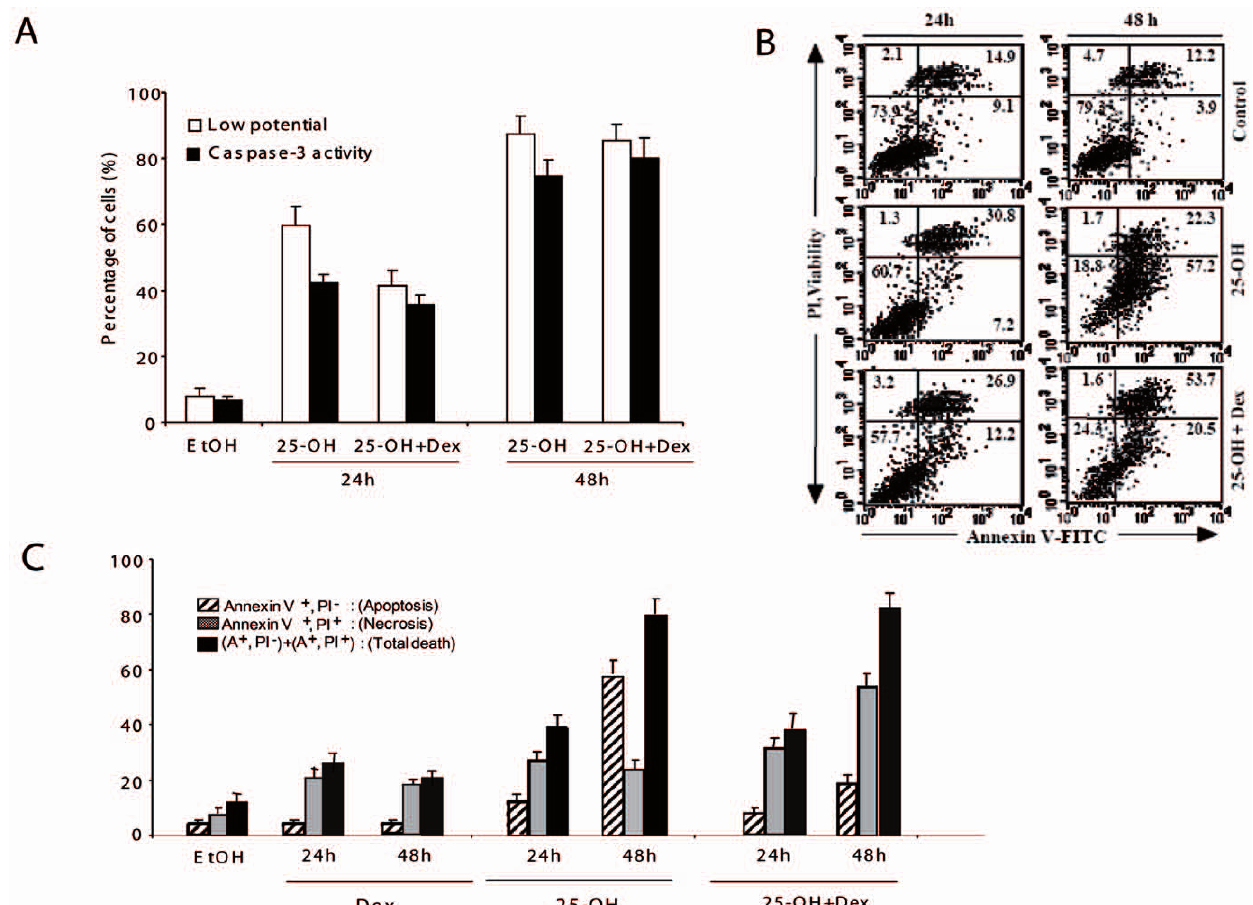
Figure 6. Cross-talk between oxysterols and glucocorticoids in oligodendrocyte death. A/ Histograms showing cells treated with or without 25-OH in presence or absence of dexamethasone. As described here, the mitochondrial membrane potential was determined by DiOC6(3) and propidium iodide staining of the cells, followed by flow cytometry analysis. The different categories of cell populations as described in (A) have been simultaneously plotted. In all cases, 10.000 cells have been counted. The standard deviations have been extracted from five different experiments. B/ Biparametric flow cytometric analysis of oligodendrocytes treated with or without 25-OH in presence or absence of dexamethasone. Apoptotic cells were identified as Annexin V-FITC positive/PI negatives, whereas necrotic cells or cells exhibiting secondary necrosis were considered as Annexin V-FITC positive and PI positive. The addition of the two populations gives the total cell death in the present conditions. A typical experiment with cells treated for 24 h or 48 h is presented. 10.000 cells have been counted for each representation (the cell debris and aggregated cells have been excluded from the analysis by selection based on their light scattering properties). C/ Histograms of the cells treated with or without 25-OH in the presence or absence of dexamethasone. The different categories of cell populations as described in (B) have been simultaneously plotted. In all cases 10.000 cells have been counted. The standard deviations have been extracted from five independent experiments.